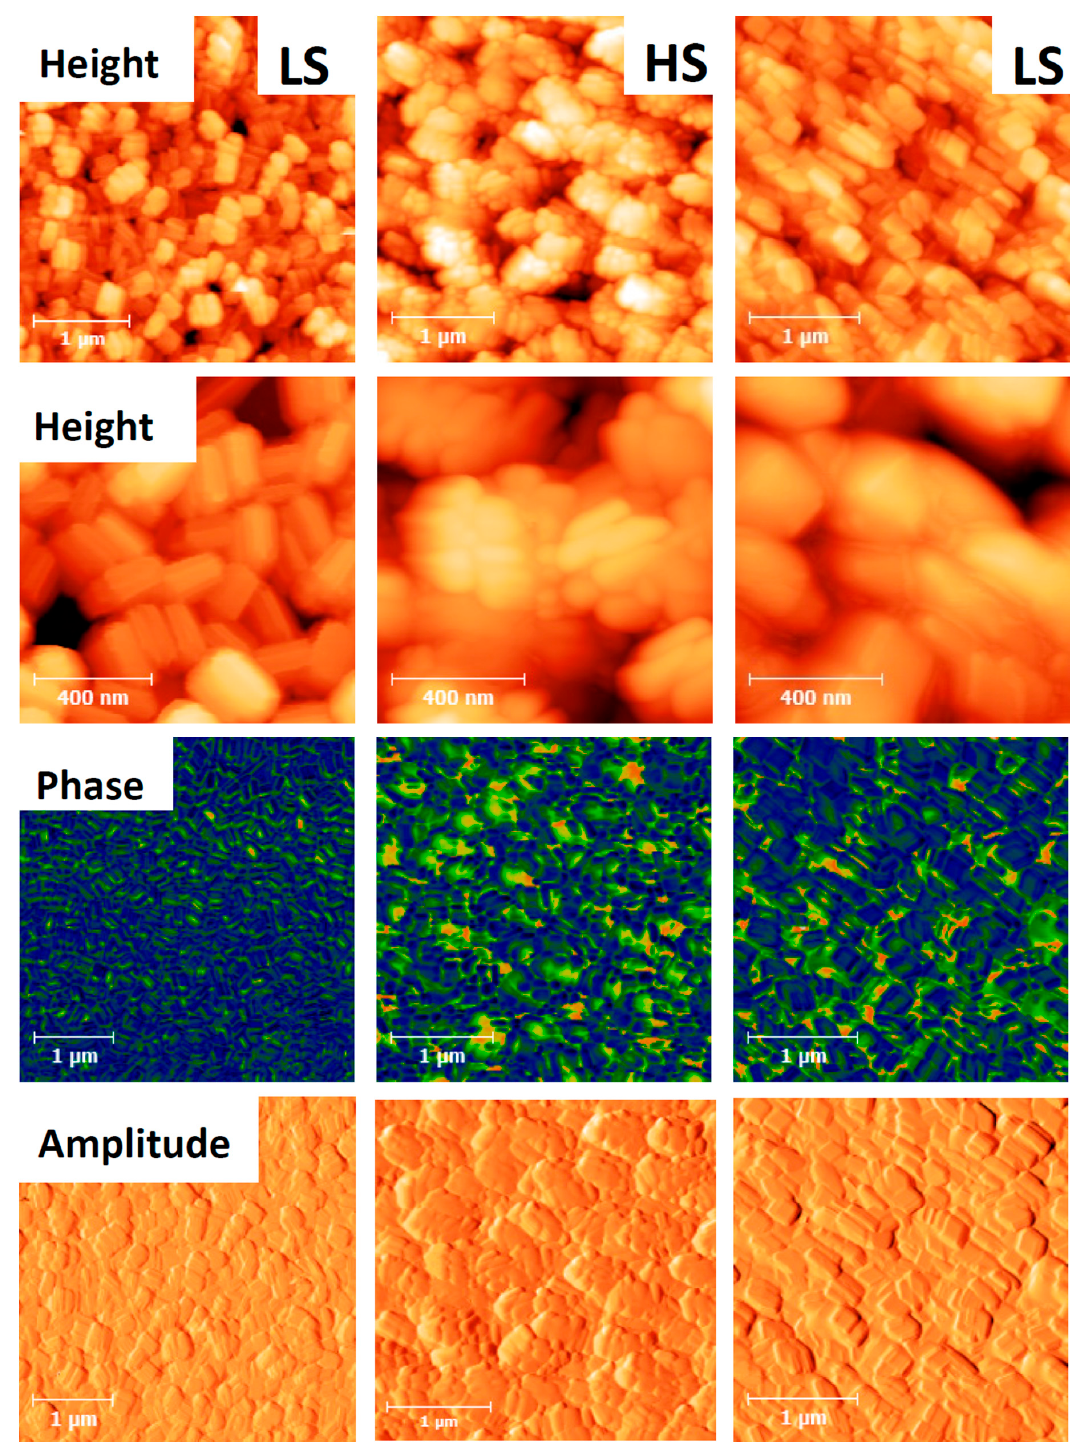
Figure 3. AFM images of 1 acquired during a complete thermal cycle. From left to right: LS (303 K), HS (360 K) and LS (360 K) states. From top to bottom: height (scan size: 3 × 3 μ m 2 and 1 × 1 μ m 2 ), phase and amplitude signals. Images were recorded at 512 × 512 pixels at a line rate of 1 Hz. The z-scale ranges from 0 to 300 nm (height) and from 0 to 90 degrees (phase).